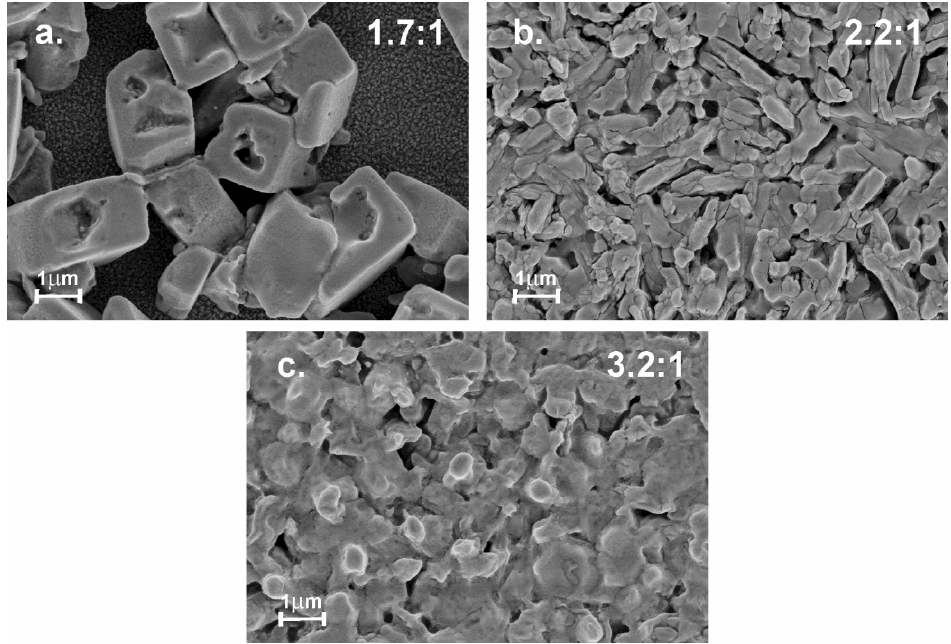
Figure 12. SEM images of FAPI films prepared at room temperature and PbI 2 / FAI thickness ratio of ( a ) 1.7: 1, ( b ) 2.2: 1 and ( c ) 3.2: 1.